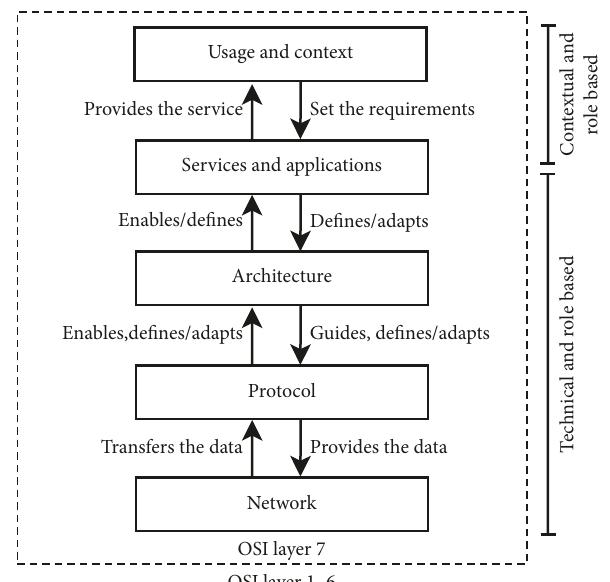
Figure 4: Network management responsibility stack and the re- lations between the layers. The stack resides on the application layer of the OSI